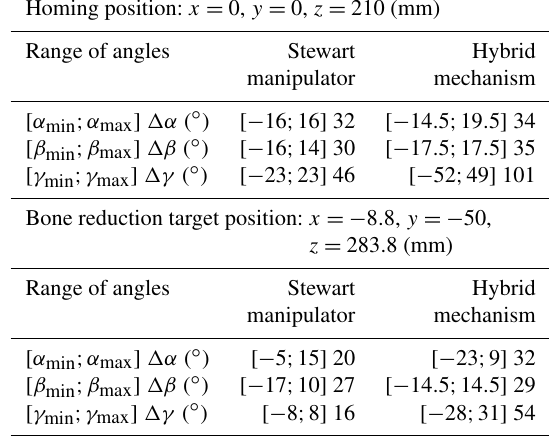
along x axis, 150 mm along y axis and 165 mm along z Table 1. Ranges of angular motions at homing and bone reduction target positions of the hybrid mechanism and Stewart